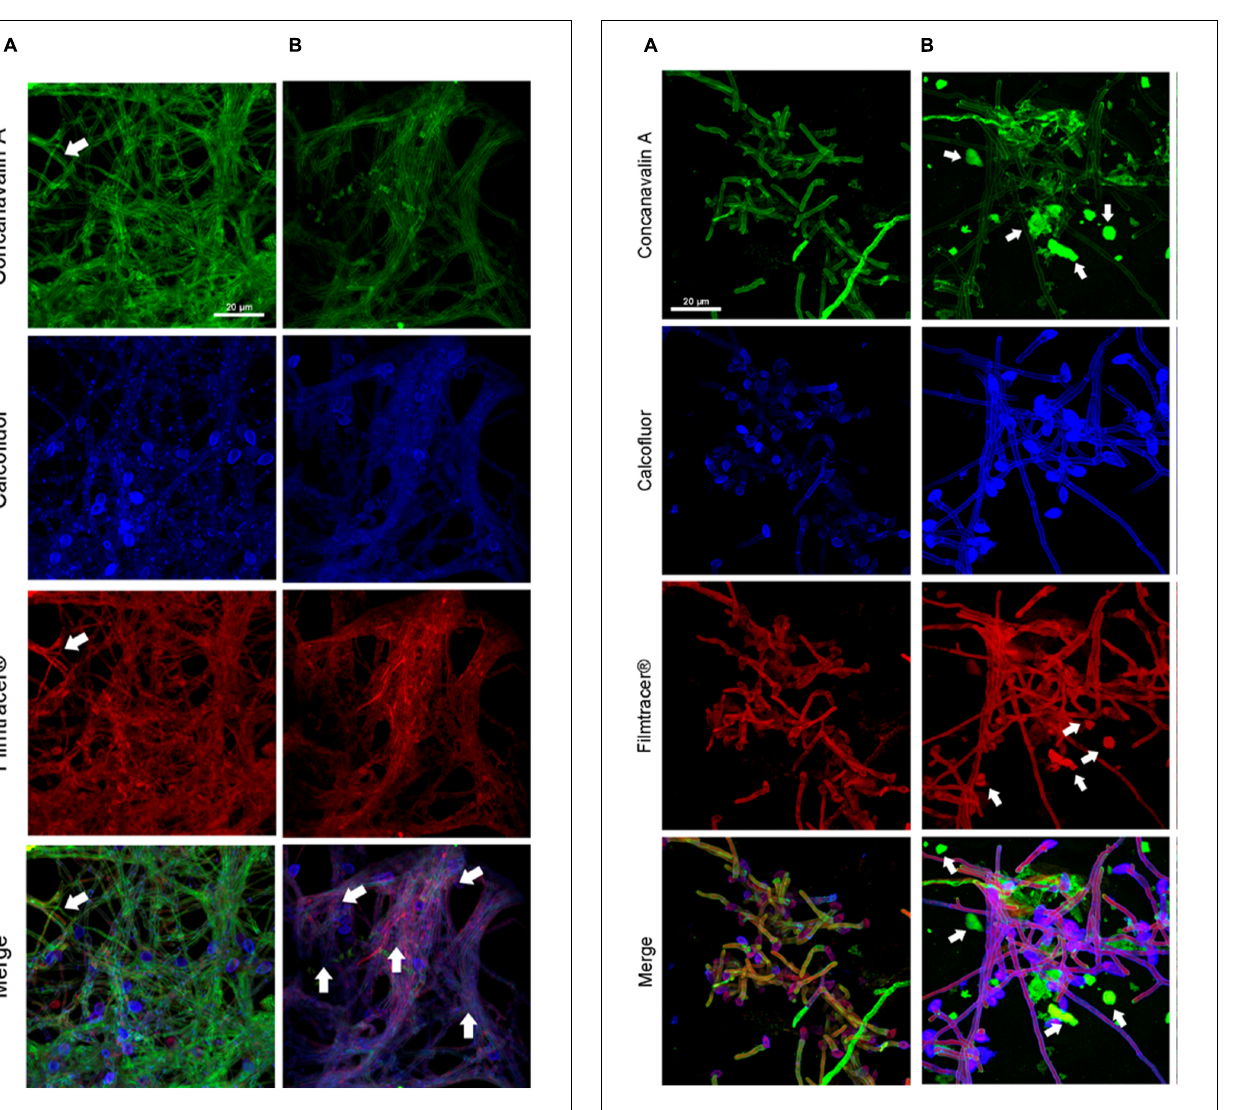
FIGURE 3 | Confocal laser scanning microscopy of S. boydii biofilms grown for 12 h in vitro . (A) S. boydii CBS 120157 and (B) S. boydii CBS 117410. In the panels, glucose-mannose residues were stained using concanavalin A-Alexa 488 (green panel), cell walls and matrix chitin were stained using calcofluor white (blue panels) and glycoproteins were stained using the biofilm-tracer FilmTracer R (cid:13) Sypro ruby (red panels). White arrows indicate accumulated extracellular matrix. The same magnification (63 × ) was used in all panels.